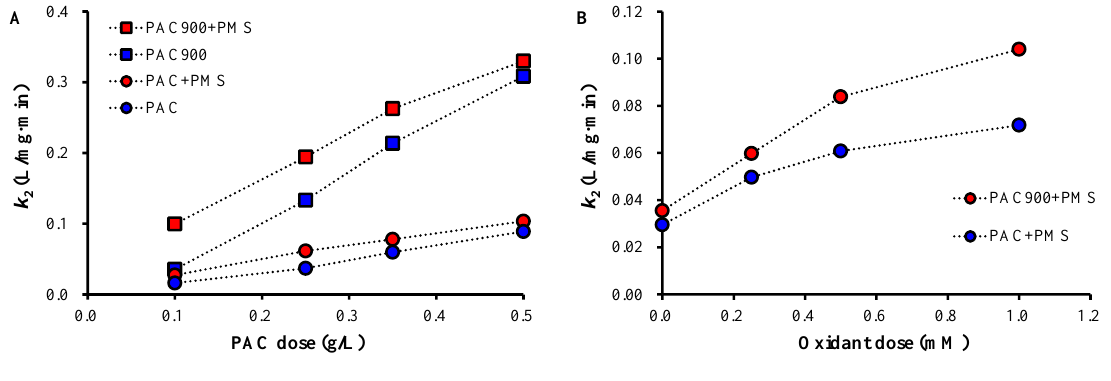
Figure 6. The pseudo second-order rate constants of OTC removal ( k 2 ) at different dose of ( A ) PAC or PAC900 (PMS 1 mM) and ( B ) PMS (PAC or PAC900 0.1 g/L) (OTC 25 mg/L, initial pH 6.0, 20 ± 2 °C).